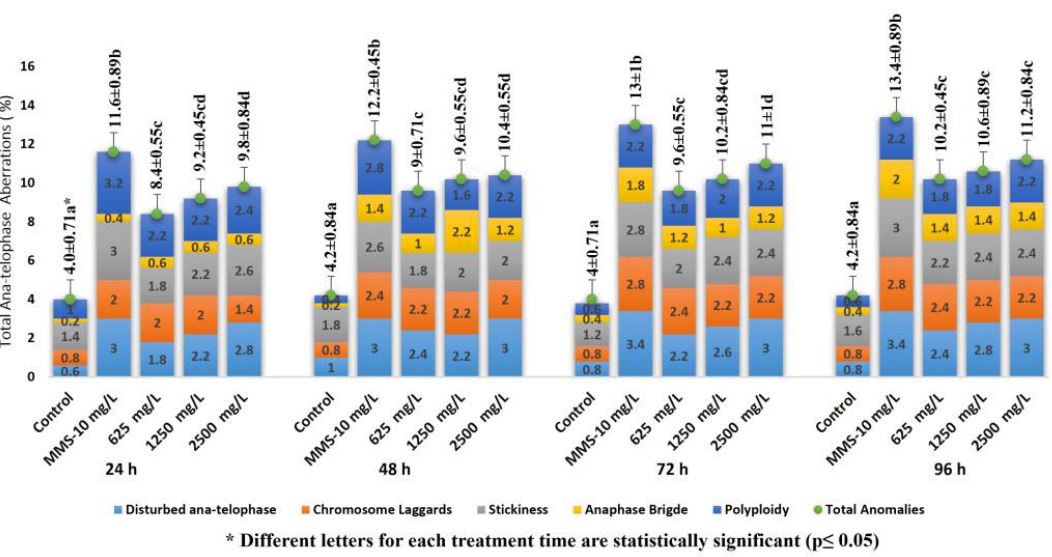
Figure 2. The variation of the total number of CAs in A. cepa root cells depending on FLB concentrations and time exposure. Dose dependent: For 24 h, r = 0.71; p = 0.01. For 48 h, r = 0.725; p = 0.01. For 72 h, r = 0.616; p = 0.05. For 96 h, r = 0.518; p = 0.05. Time dependent: For 625 mg/L, r = 0.635; p = 0.01. For 1250 mg/L, r = 0.646; p = 0.01. For 2500 mg/L, r = 0.586; p = 0.01.